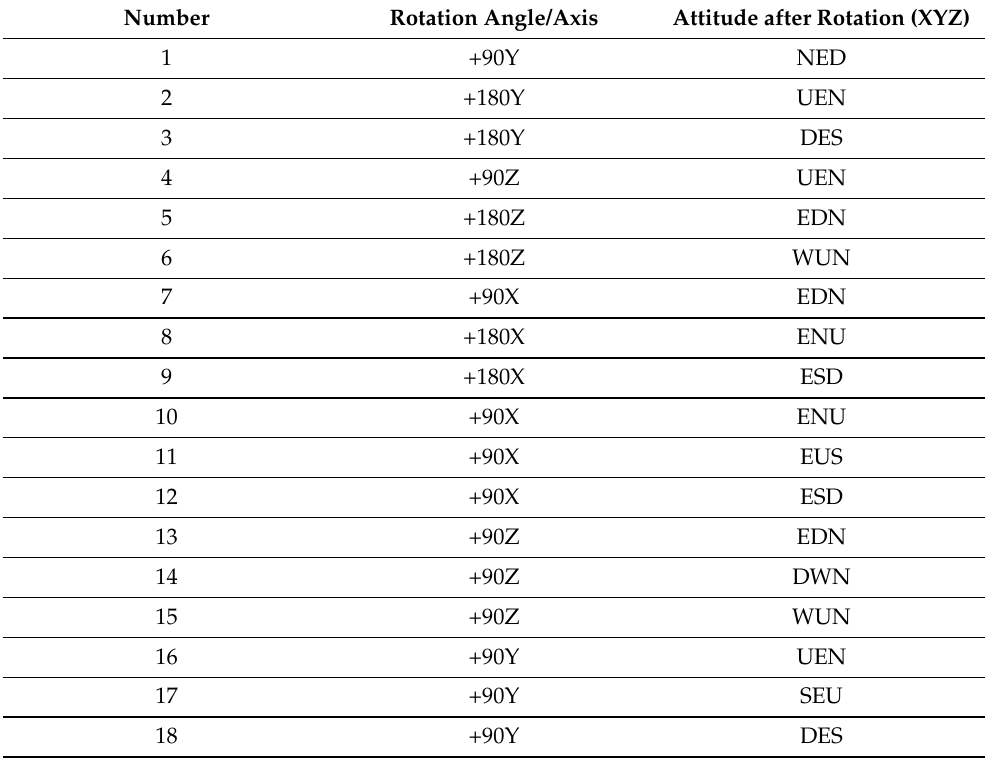
Table 1. Rotation path of systematic